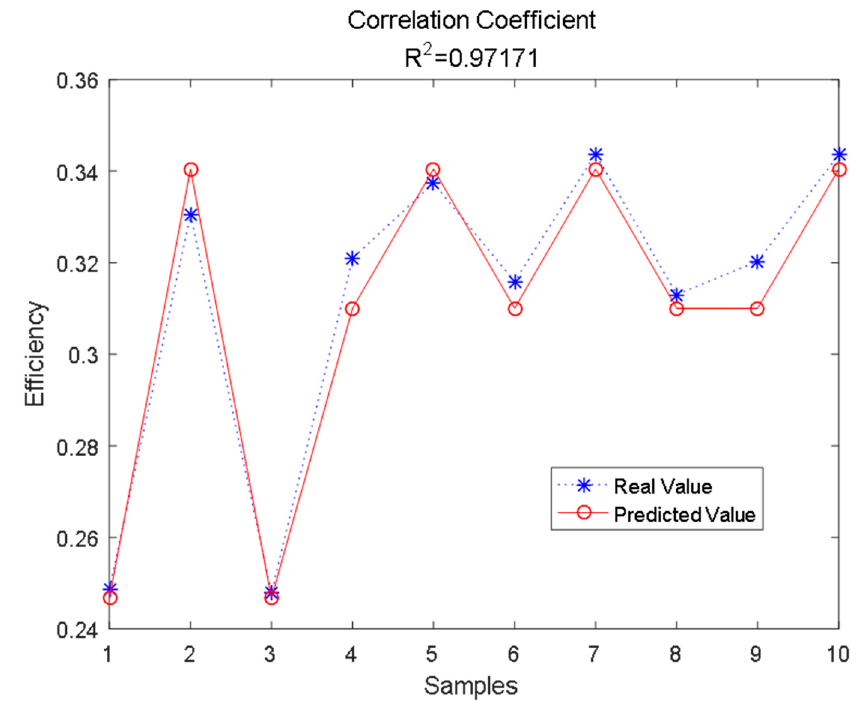
Figure 8. Efficiency predicted value by BP without learning rate optimization ( η = 0.01).